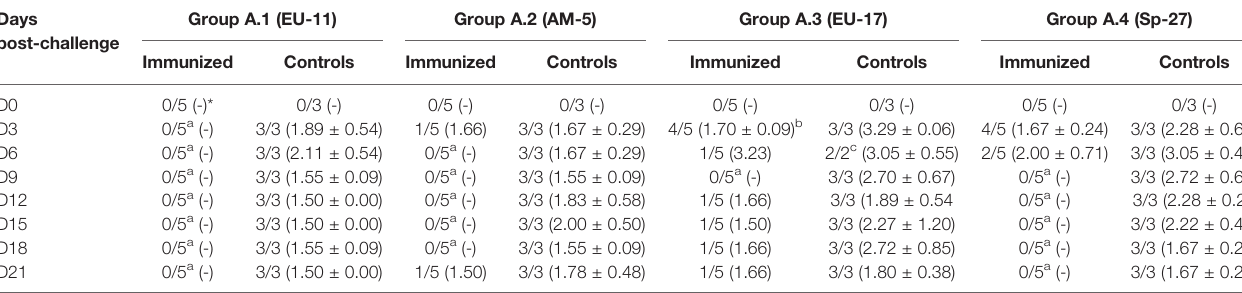
TABLE 3.1 | Virus isolation from serum samples collected in Experiment A (pigs immunized with Sp-3a). Days post-challenge